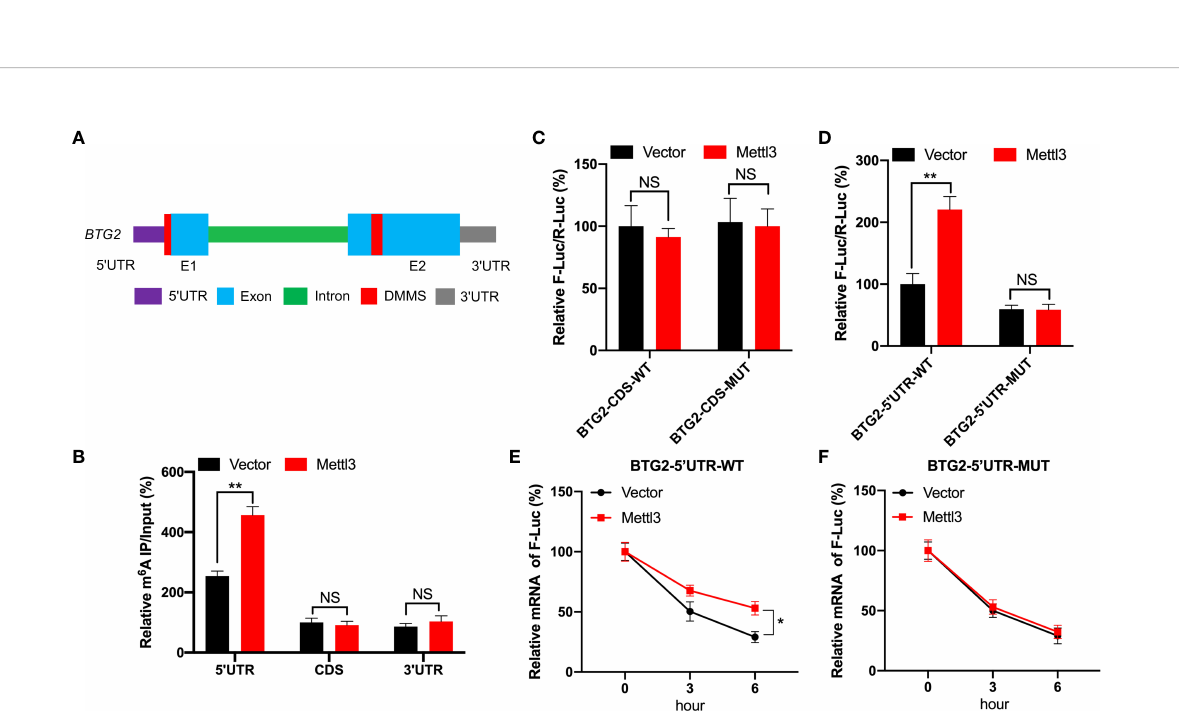
FIGURE 3 BTG2 is regulated by m 6 A modi fi cation through methylation sites. (A) Diagram showing DMMs positions within BTG2 mRNA. (B) The MeRIP- qPCR assay was used to analyze the m 6 A enrichment in different regions of BTG2 mRNA in control or Mettl3 overexpression 786O cells. (C) F- Luc/R-Luc activity in control and Mettl3-overexpressing 786O cells transfected with pmirGLO-BTG2-CDS-WT or pmirGLO-BTG2-CDS-MUT. (D) F-Luc/R-Luc activity in control and Mettl3-overexpressing 786O cells transfected with pmirGLO-BTG2-5 ’ UTR-WT or pmirGLO-BTG2- 5 ’ UTR-MUT. E-F. The mRNA expression levels of pmirGLO-BTG2-5 ’ UTR-WT (E) or pmirGLO-BTG2-5 ’ UTR-MUT (F) in 786O cells after overexpressing Mettl3 and treatment with ActD for indicated times. * P<0.05, ** P<0.01, NS means No signi fi cance.